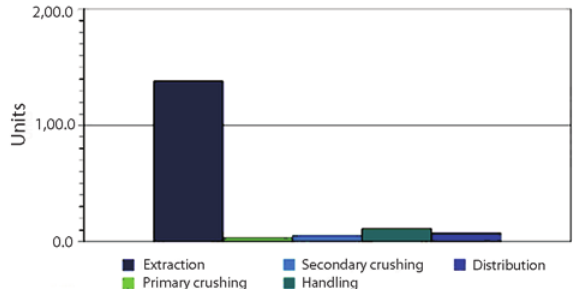
Fig. 11. Energy of individual phases for inert crushed